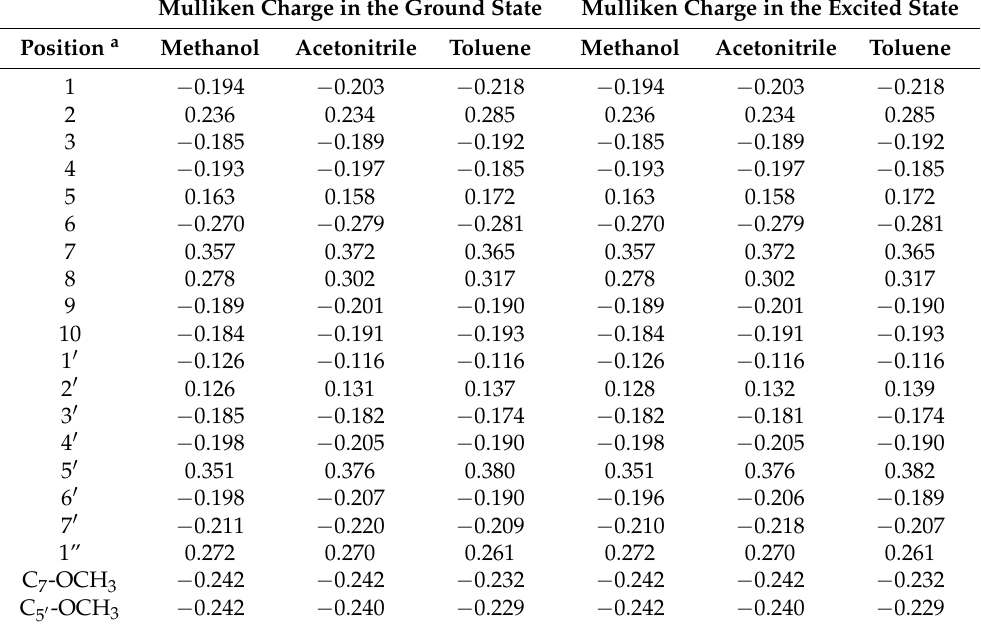
Table 3. Mulliken charge values for the compound 7 in both ground and excited state. Mulliken Charge in the Ground